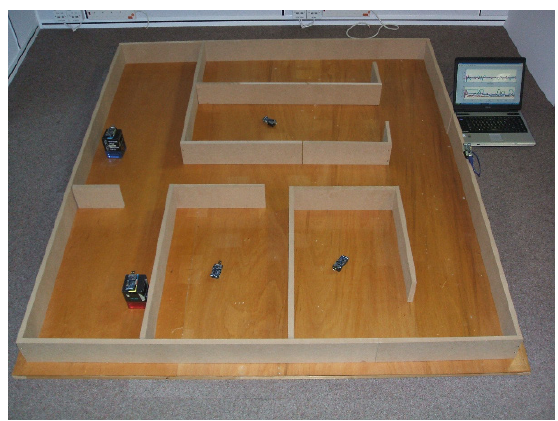
Figure 2. Mindstorm Robotic Test-bed